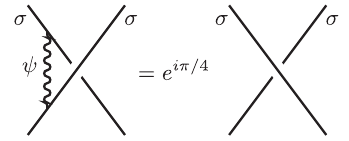
FIG. 5. The effect of a diabatic error, which transfers a neutral fermion from the qubit to the ancillas, on the braiding. For Ising anyons, it turns a counterclockwise braiding into a clockwise one, up to an overall phase.